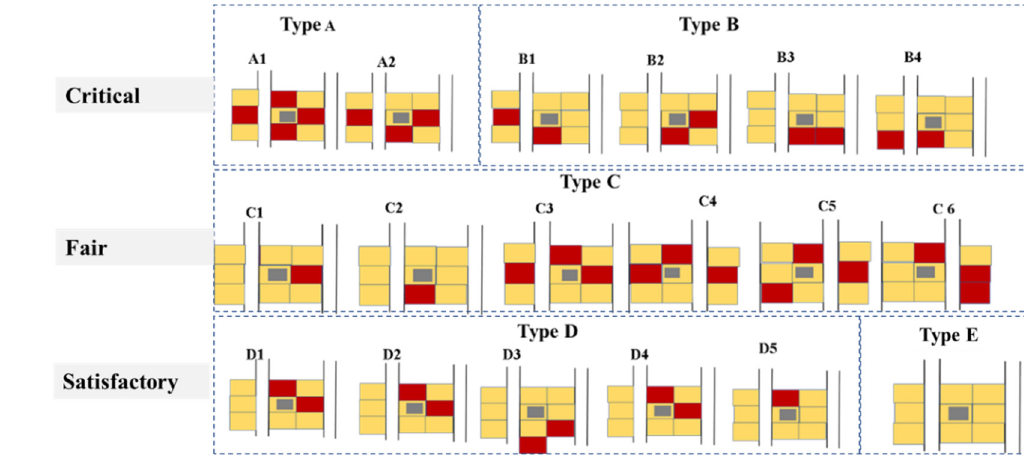
Figure 10. Categories for location layout of living environmental and social influences.